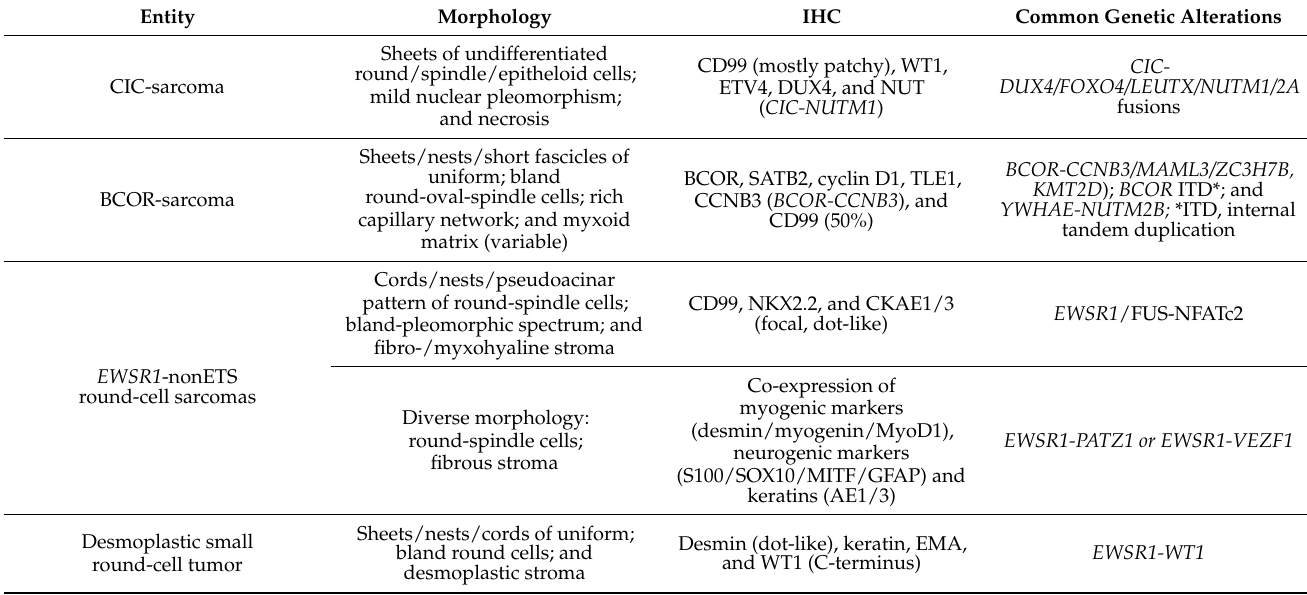
Table 1. Differential diagnoses of Ewing